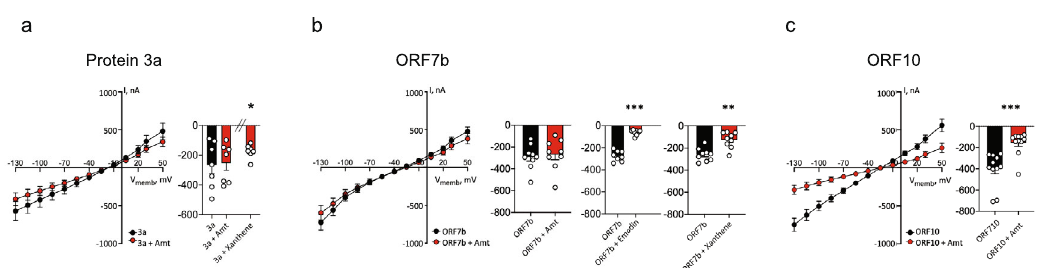
Fig. 5 All four viroporins of SARS-CoV-2 can be blocked by drugs. a Protein 3a-, b ORF7b-, and c ORF10-mediated current activity was monitored in the absence and presence of selected drugs (10 µ M). Amantadine was ineffective on Protein 3a ( a ) and ORF7b ( b ), but blocked the activity of ORF10 ( c ). Xanthene blocked the activity of both Protein 3a ( a ) and ORF7b ( b ), while emodin blocked ORF7b ( c ). a – c Current activity at − 85 mV with the treatment of the speci fi c drugs normalized to the current activity obtained without treatment. Statistical signi fi cance was determined with unpaired Student t test, ** P < 0.01; *** P < 0.001, of n = 3 biologically independent